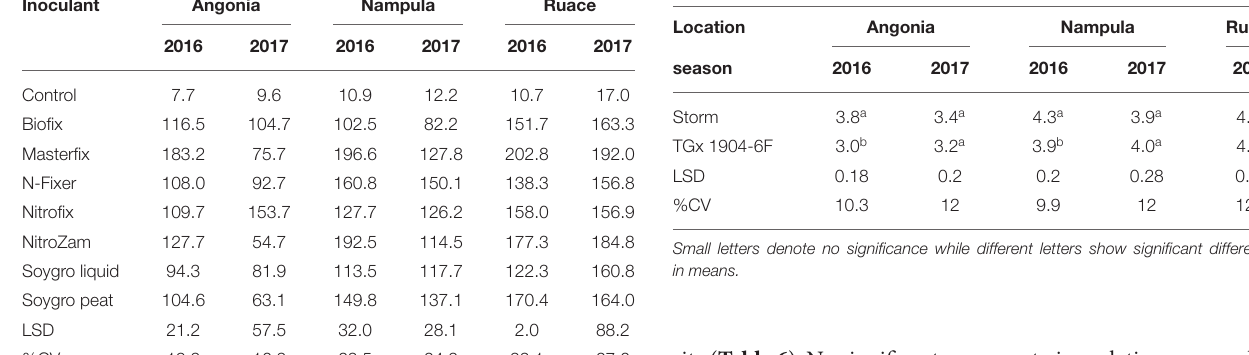
TABLE 5 | Varietal differences of mid-season biomass (R3) percent nitrogen content of inoculated soybean.